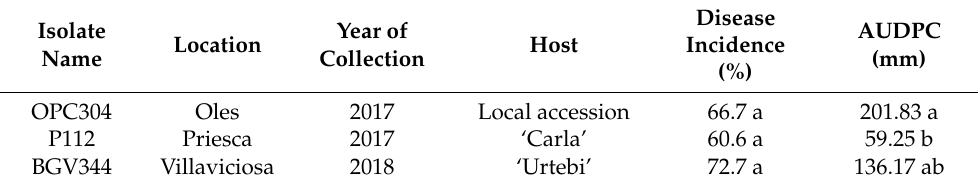
Table 2. Isolate name, origin (location and year of collection), and host of the N. ditissima isolates used to determine their pathogenicity on a series of controlled inoculations experiments on ‘M9’ potted plants. The disease incidence (expressed as the percentage of infected wounds) and AUDPC (area under the disease progress curve) values were obtained 42 days after the inoculation. Values followed by a different letter differ significantly ( p < 0.05) according to the ANOVA analysis.